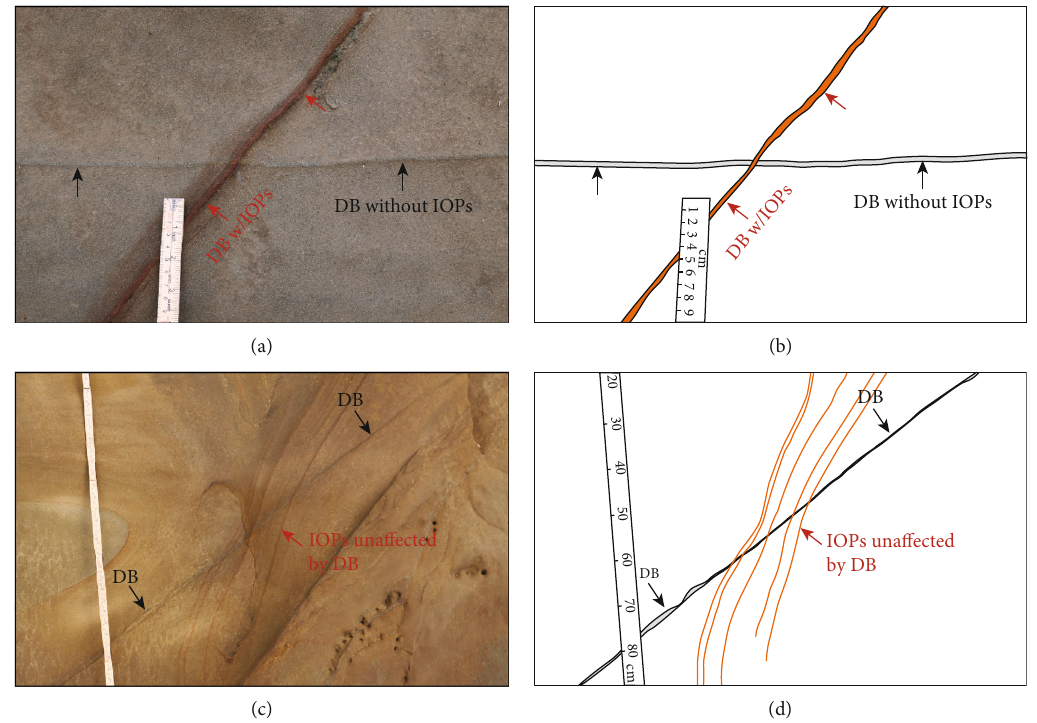
Figure 6: (a) Field photo and (b) sketch of a deformation band functioning as a capillary conduit controlling oxidation (red arrows) and a deformation band without any oxidation at all (black arrows: horizontal in picture, dipping away from perspective); Taranaki coast, New Zealand. (c) Field photo and (d) sketch of example where bands of iron oxide precipitates (pointed out by red arrow) clearly ignore a deformation band (black arrows); Taranaki coast, New Zealand.